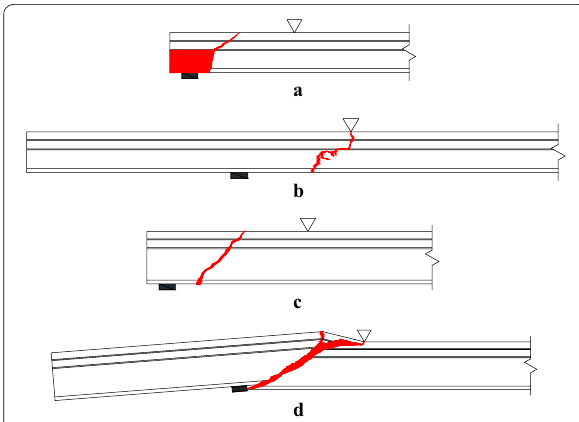
Fig. 5 Test setup. a Speicmens S2‑E, S2.65‑E, S4 and S5, b speicmens S2‑F and S2.65‑F (Unit: mm).